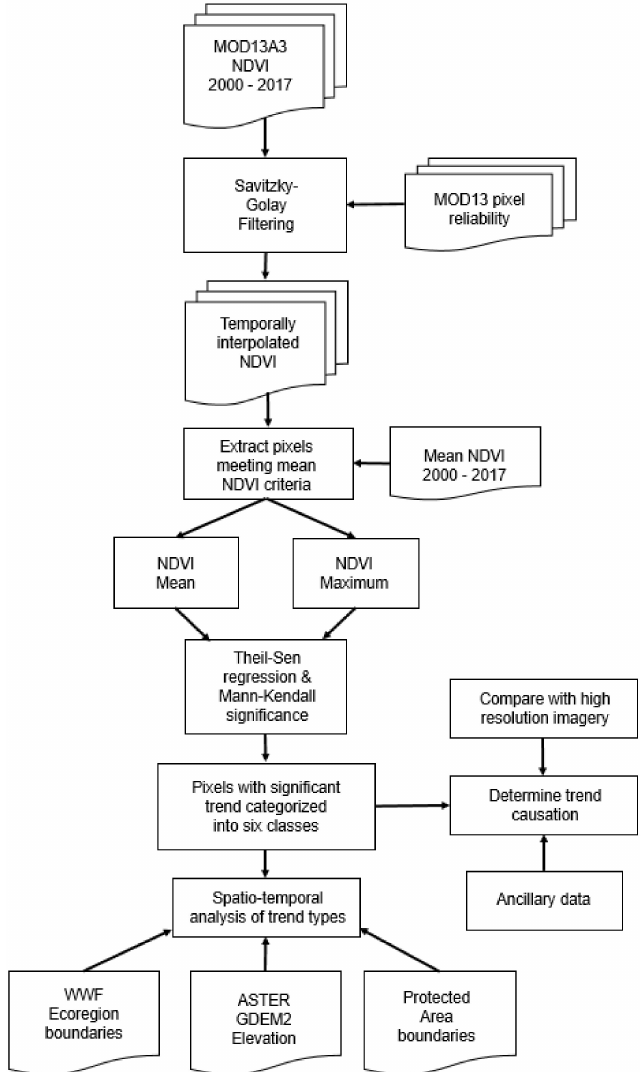
Figure 2. Workflow of the remote sensing pre-processing, trend analysis, and exploration of